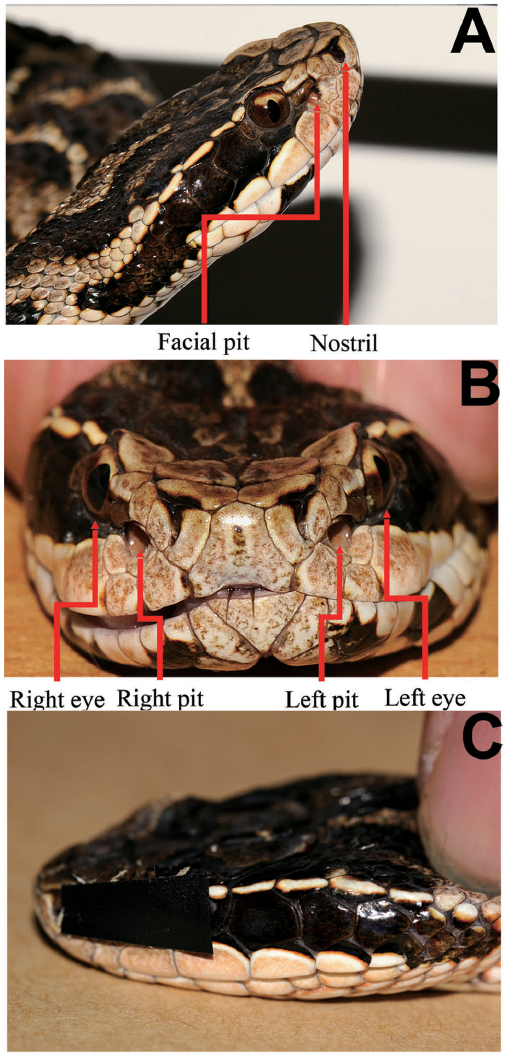
Figure 4. Positions of pits and eyes and demonstrate of sensory occlusion. A: Photograph of the head of Gloydius brevicaudus showing the location of the lateral facial pit organ between the ipsilateral eye and nostril. B: Photograph of the rostral view of the head of G. brevicaudus showing both eyes and facial pits. C: A photograph of an experimental subject illustrating left side sensory occlusion (see Materials and Methods for explanation).